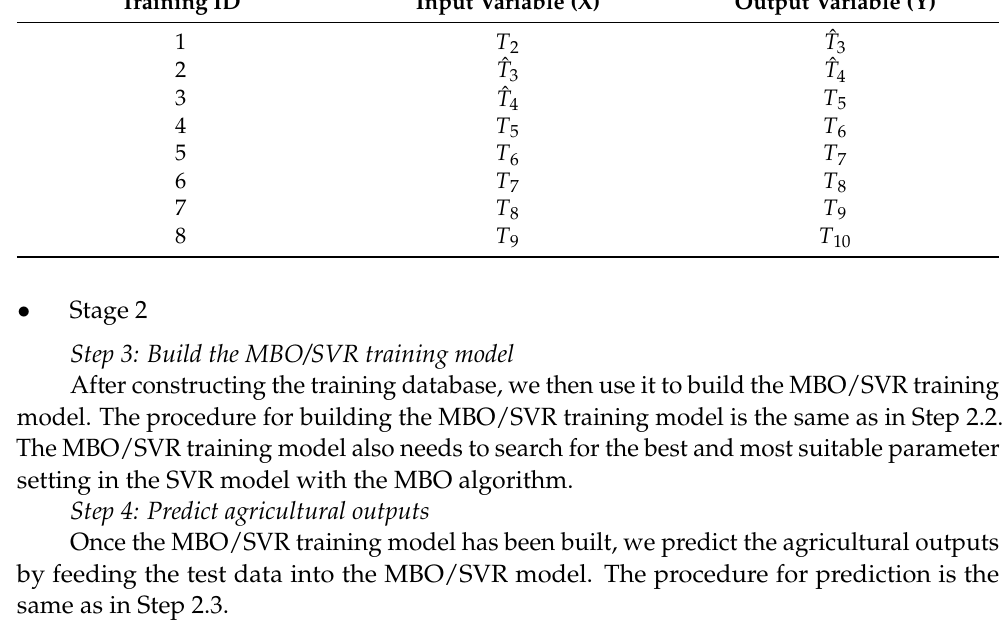
Table 4. An example of a training database with outlier predictions.